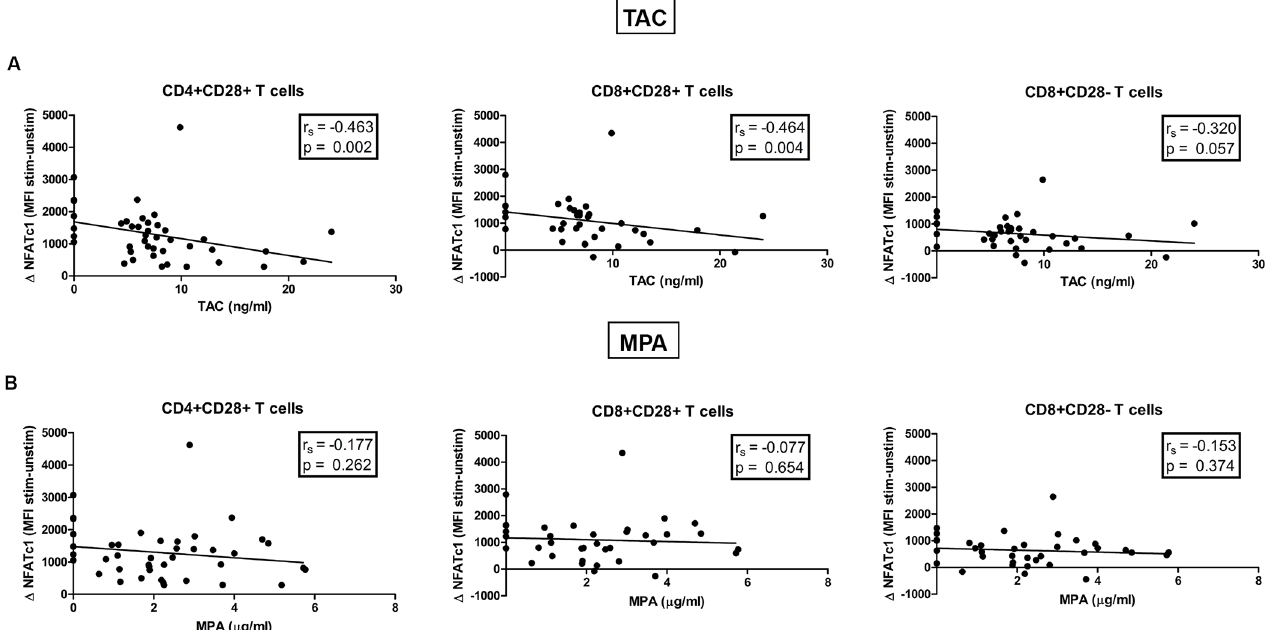
Fig 5. Spearman correlations of NFATc1 amplification with TAC or MPA pre-dose concentrations. (A) NFATc1 amplification inversely correlated with TAC pre-dose concentrations in time. The correlation was only seen in CD4 + CD28 + ( left graph ) and CD8 + CD28 + cells ( middle graph ) and not in CD8 + CD28 - cells ( right graph ). (B) MPA pre-dose concentrations were not correlated to NFATc1 amplification levels in CD4 + CD28 + ( left graph ) and CD8 + CD28 + cells ( middle graph ) nor in CD8 + CD28 - cells ( right graph ). TAC-treated patients were included for this analysis when blood samples were analyzed for NFATc1 amplification at all time points: before transplantation and day 4, 30, 90, 180 and 360 after transplantation. N = 7; r s, Spearman correlation coefficient.